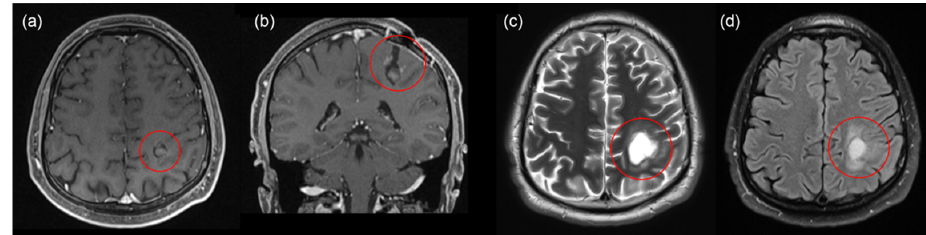
Figure 2. MRI 1.5 T with contrast before and after the second surgery. Before surgery: T1 axial ( a ), coronal ( b ) projections. After surgery: T2 axial ( c ), T2 flair axial ( d ). No recurrent tumor, and no contrast uptake in the tumor bed.